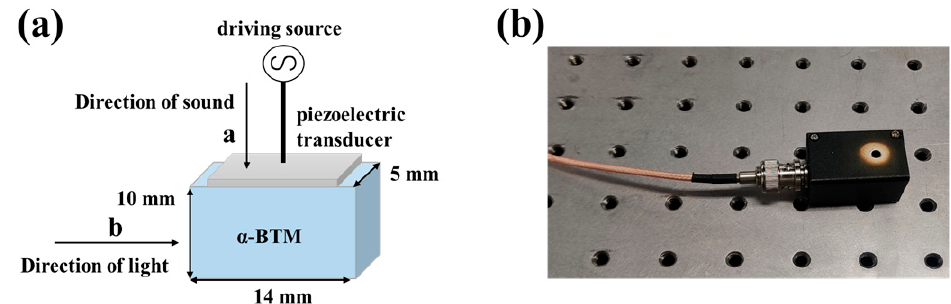
Figure 2. The schematic diagram ( a ) and photo ( b ) of the α -BTM AO Q-switch.